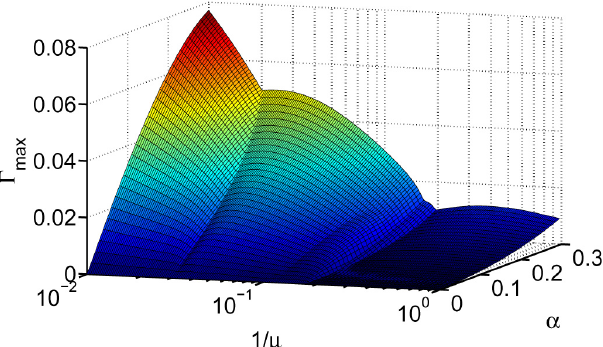
Fig. 16. (Color online) Maximum growth rate for various pump wave amplitudes α and temperatures 1 /µ , in logarithmic scale for temperature, considering all existent